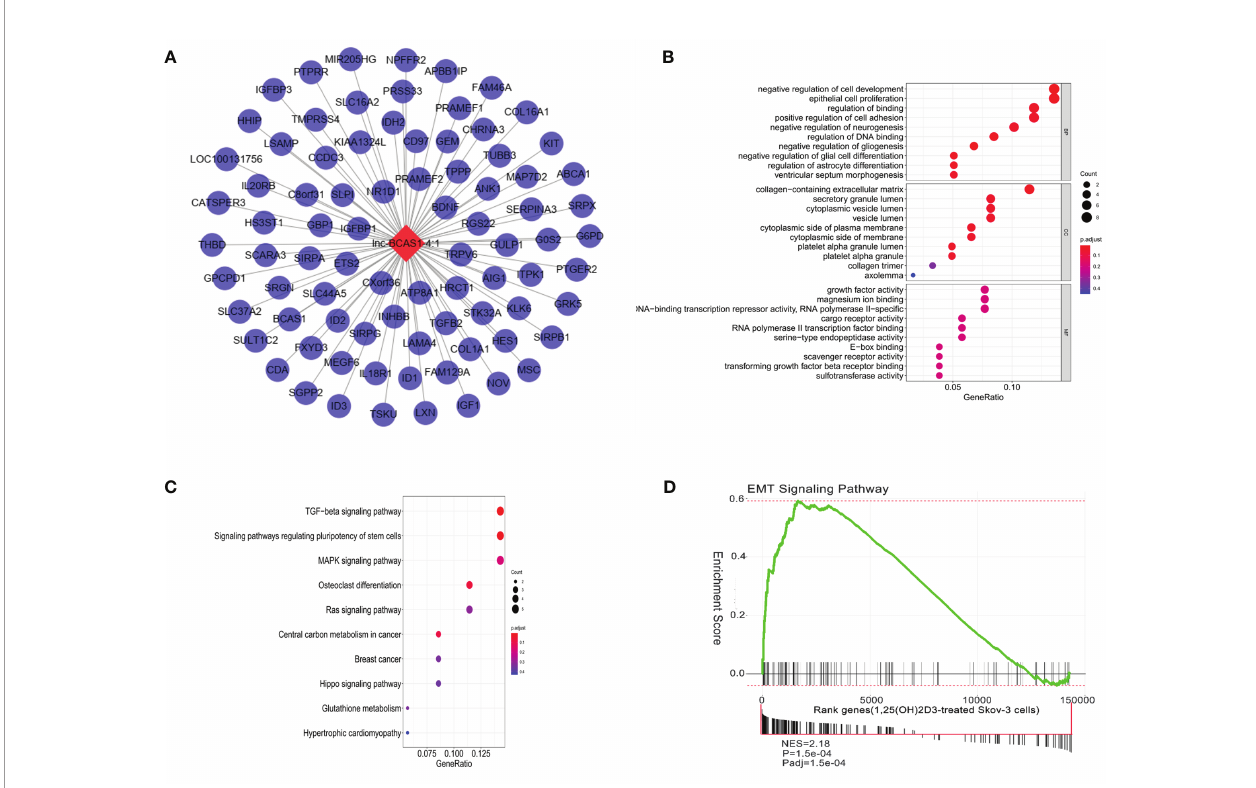
FIGURE 3 | Function analysis of lncBCAS1-4_1. (A) lncBCAS1-4_1-mRNA networks. The red nodes represent top differentiated expression lncBCAS1-4_1, and the blue nodes represent mapped mRNA. (B) GO analysis contains the biological process (BP), cellular component (CC), and molecular function (MF). The x-axis represents the gene ratio, and the y-axis represents GO terms. The size of the circle indicates the gene count, and the color means adjusted p-value. (C) The KEGG pathways from lncBCAS1-4_1 regulated DE-mRNAs. The y-axis represents the pathway, and the x-axis represents enriched gene numbers; the color means adjust p-value. (D) Gene set enrichment analysis for EMT-related lncRNA signature in 1 a ,25(OH) 2 D 3 -treated SKOV3